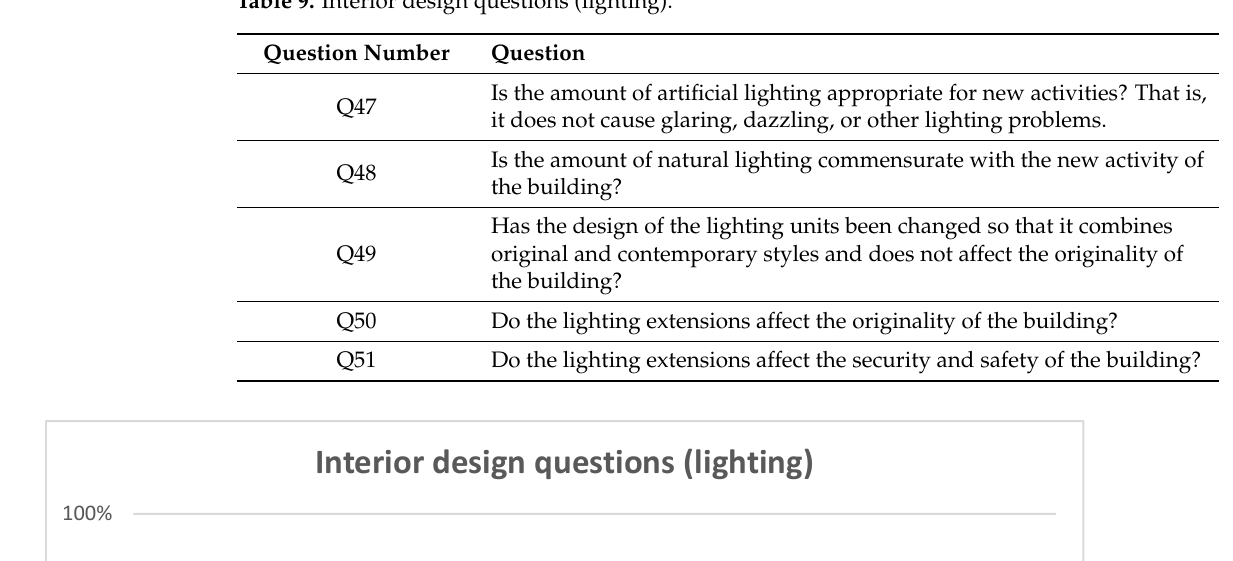
Table 9. Interior design questions (lighting).